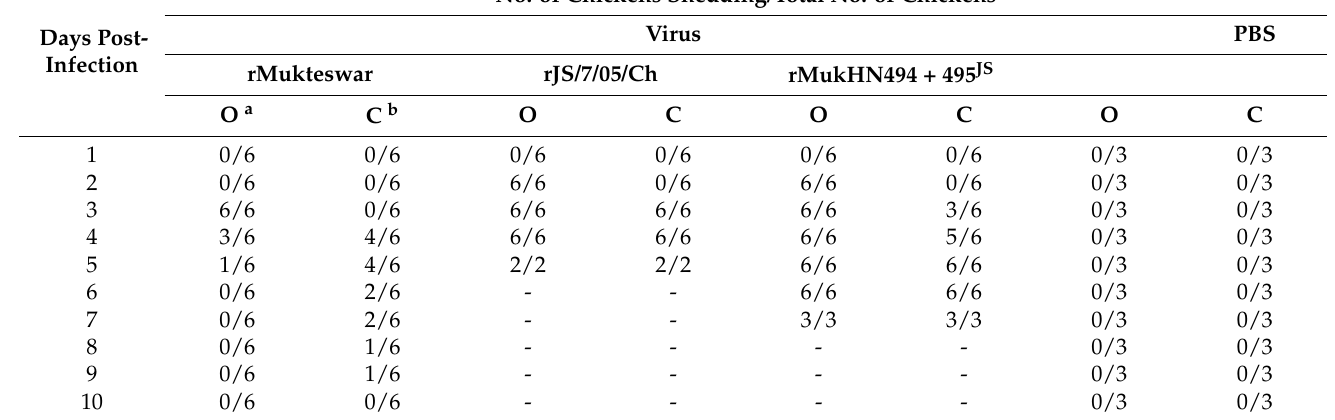
Table 3. Virus shedding in oropharyngeal and cloacal swabs of chickens, determined by inoculating